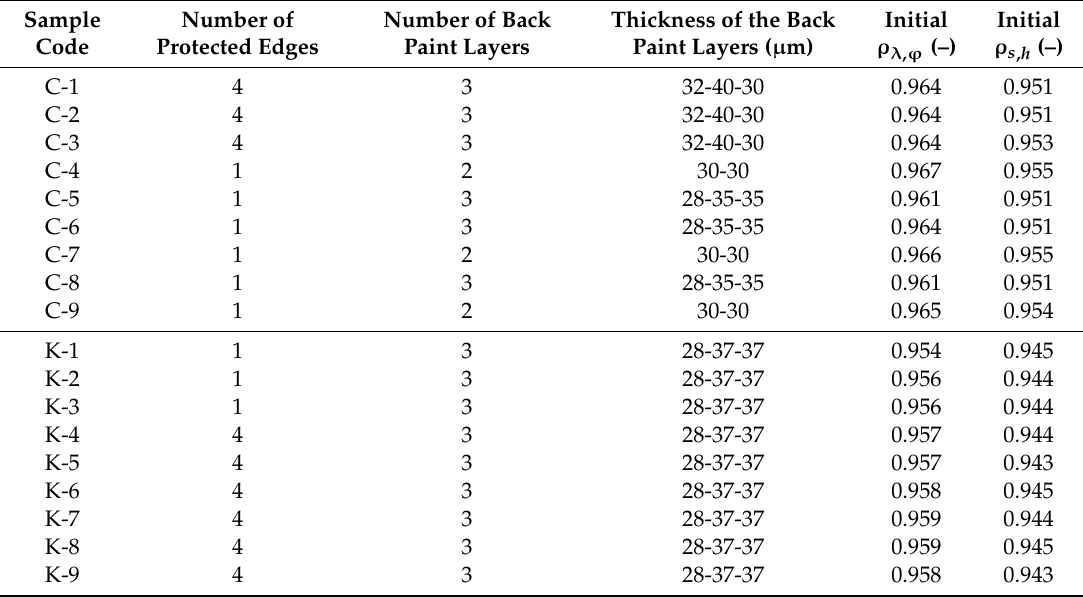
Table 1. Main characteristics of the samples